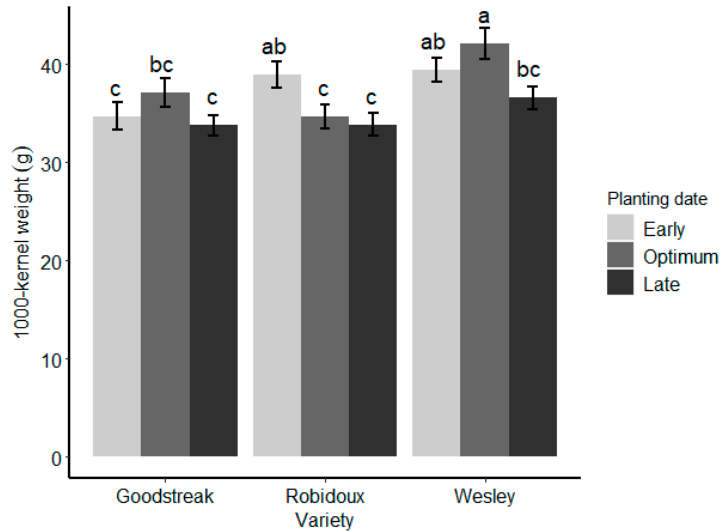
Figure 8. Effect of the interaction between planting date and variety on a 1000-kernel weight at McCook. The error bar represents the standard error of the mean. Different letters on top of column bars indicate a significant mean difference at p < 0.05.